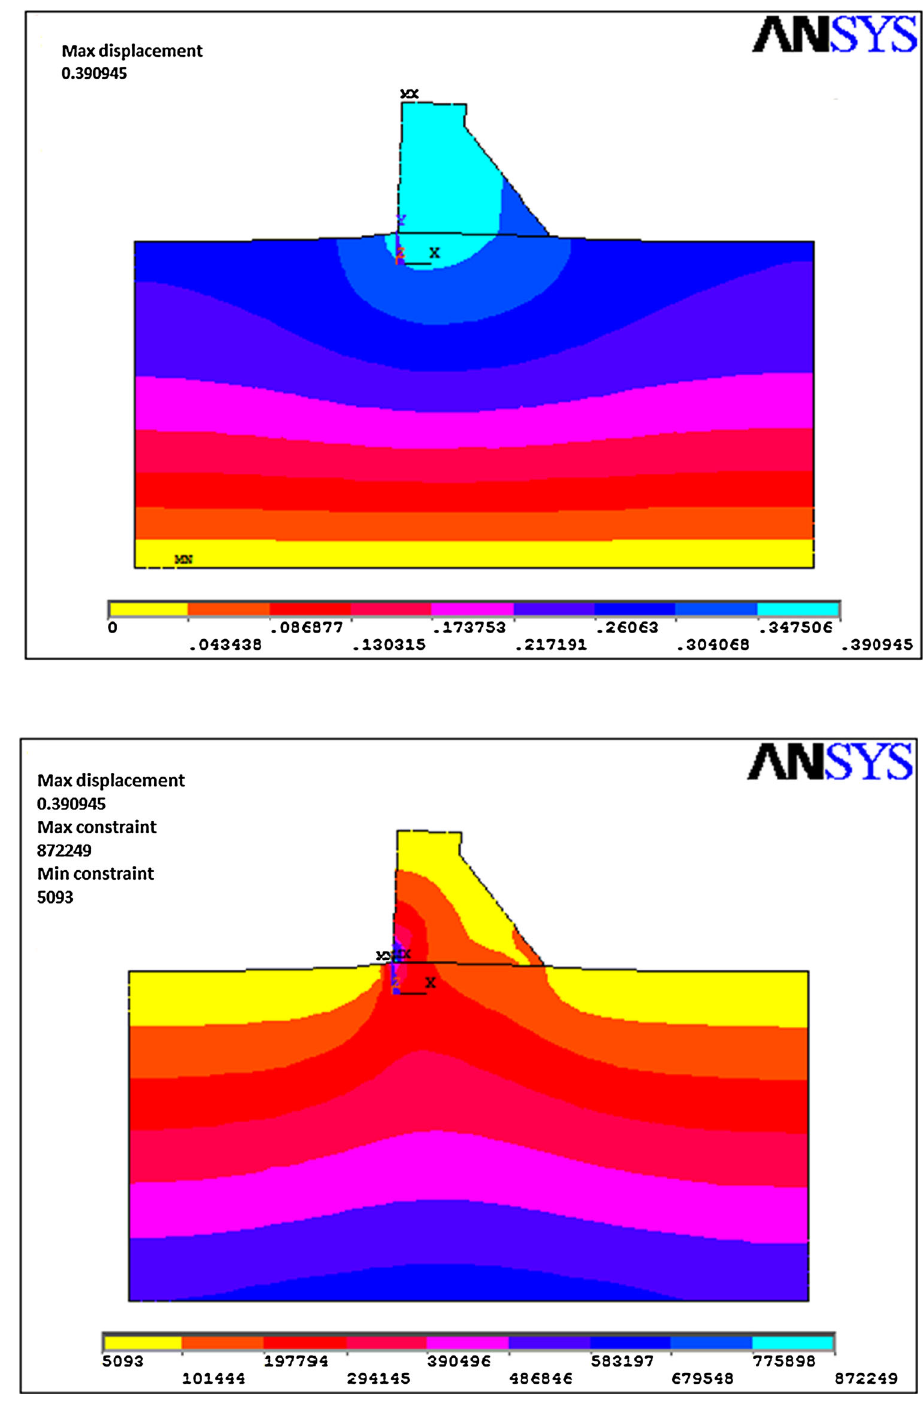
Fig. 6 Deformations (m)— RCC dam with E Fundations = 30 MPa